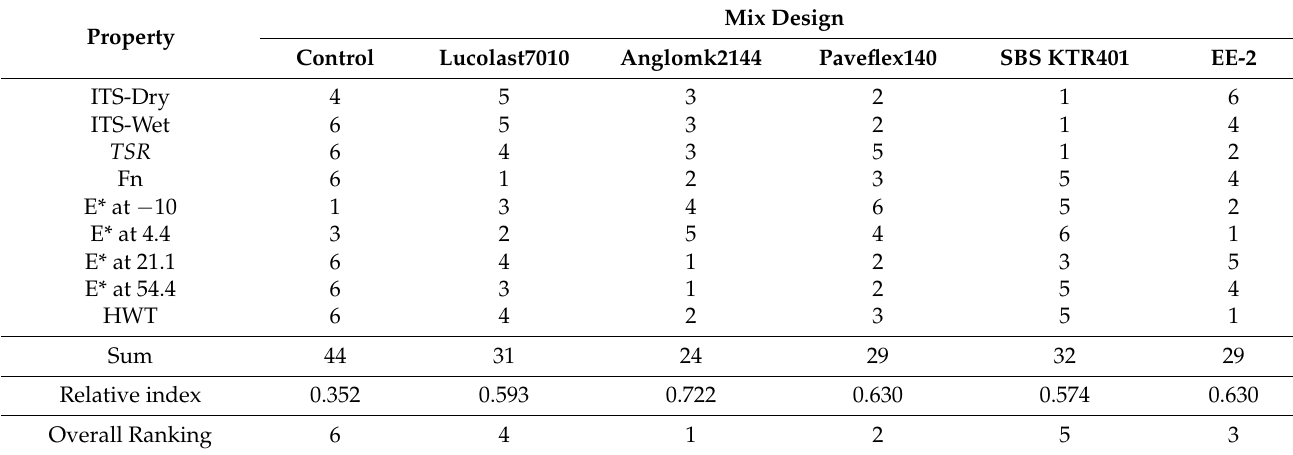
Table 16. Asphalt mixture